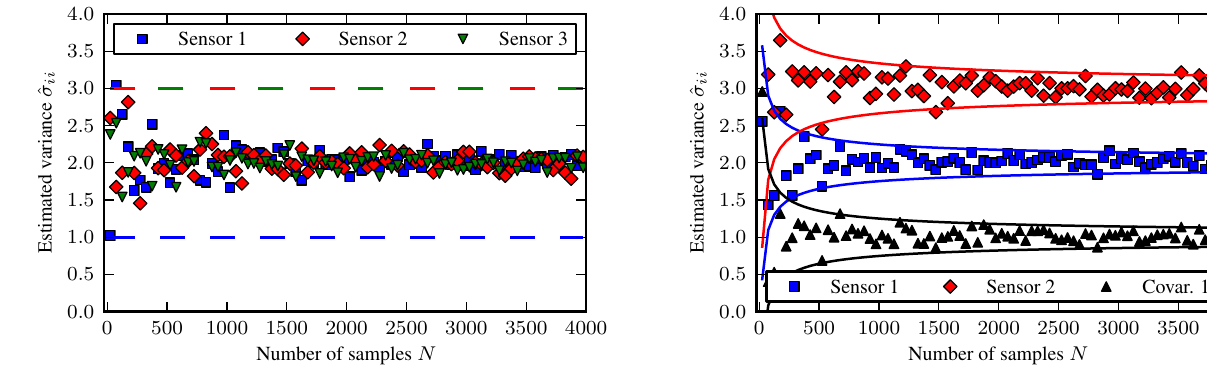
Fig. 4. Estimated variance of the three sensors computed with Eq. (4-6) in the presence of correlations. The dashed lines indicate the correct values.